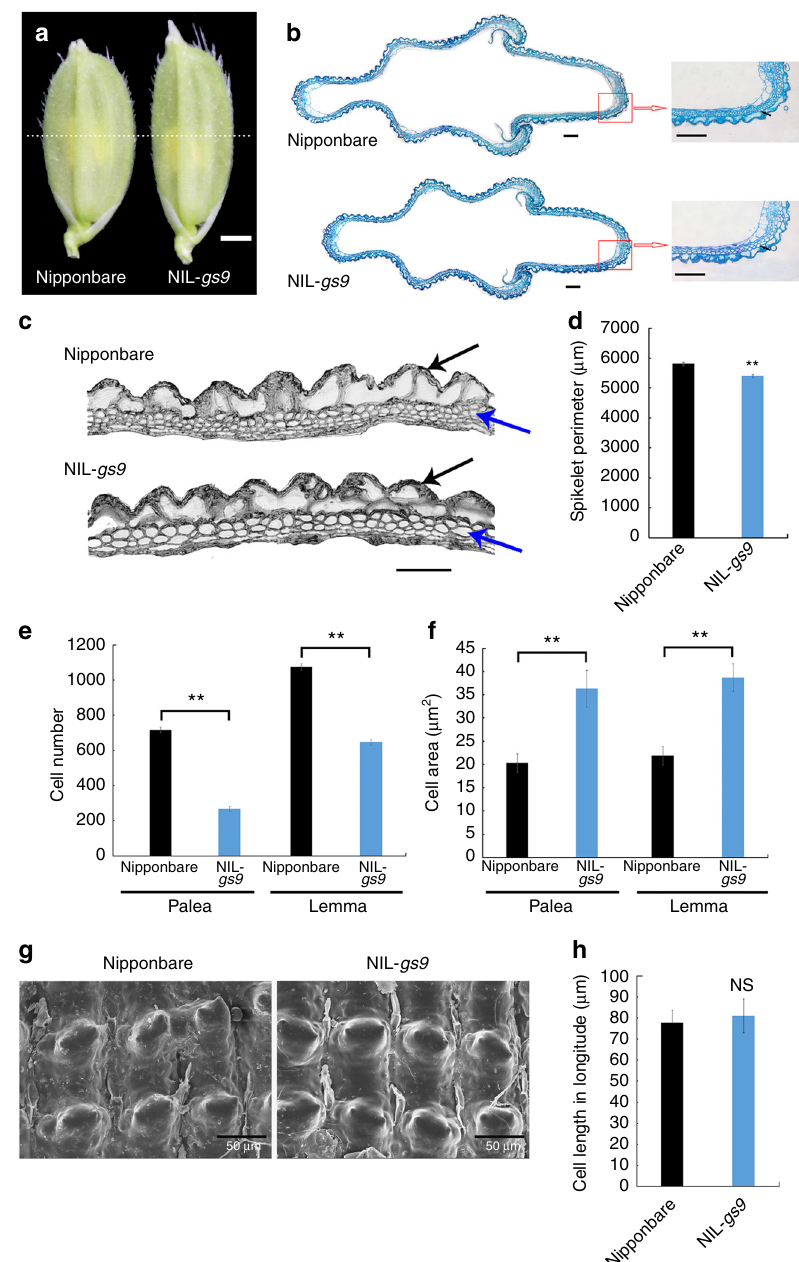
Fig. 3 Histological comparison of the spikelet hulls between NIL- gs9 and Nipponbare. a Spikelet hulls before anthesis. The white dashed line indicates the sites of the cross-sections shown in b . Scale bar, 1 mm. b Cross-sections of spikelet hulls. The right-hand images show close-up views of the boxed region. Scale bar, 100 μ m. The black arrows indicate the lower epidermis cells. c Magni fi ed views of the cross-sections indicated in b . The black and blue arrows indicate the rows of specialized cells with rigid walls and the lower epidermis cells, respectively. Scale bar, 50 μ m. Spikelet perimeter ( d ), cell number ( e ), and cell area ( f ) of palea and lemma. Data are given in means± SD, with three biological replicates. ** signi fi cant difference ( P < 0.01, t -test). g Scanning electron microscopy of the outer surfaces of the glumes. Scale bar, 50 μ m. h The cell length in longitude. Data are given as means ± SD; n = 15. NS not signi fi cant difference ( t